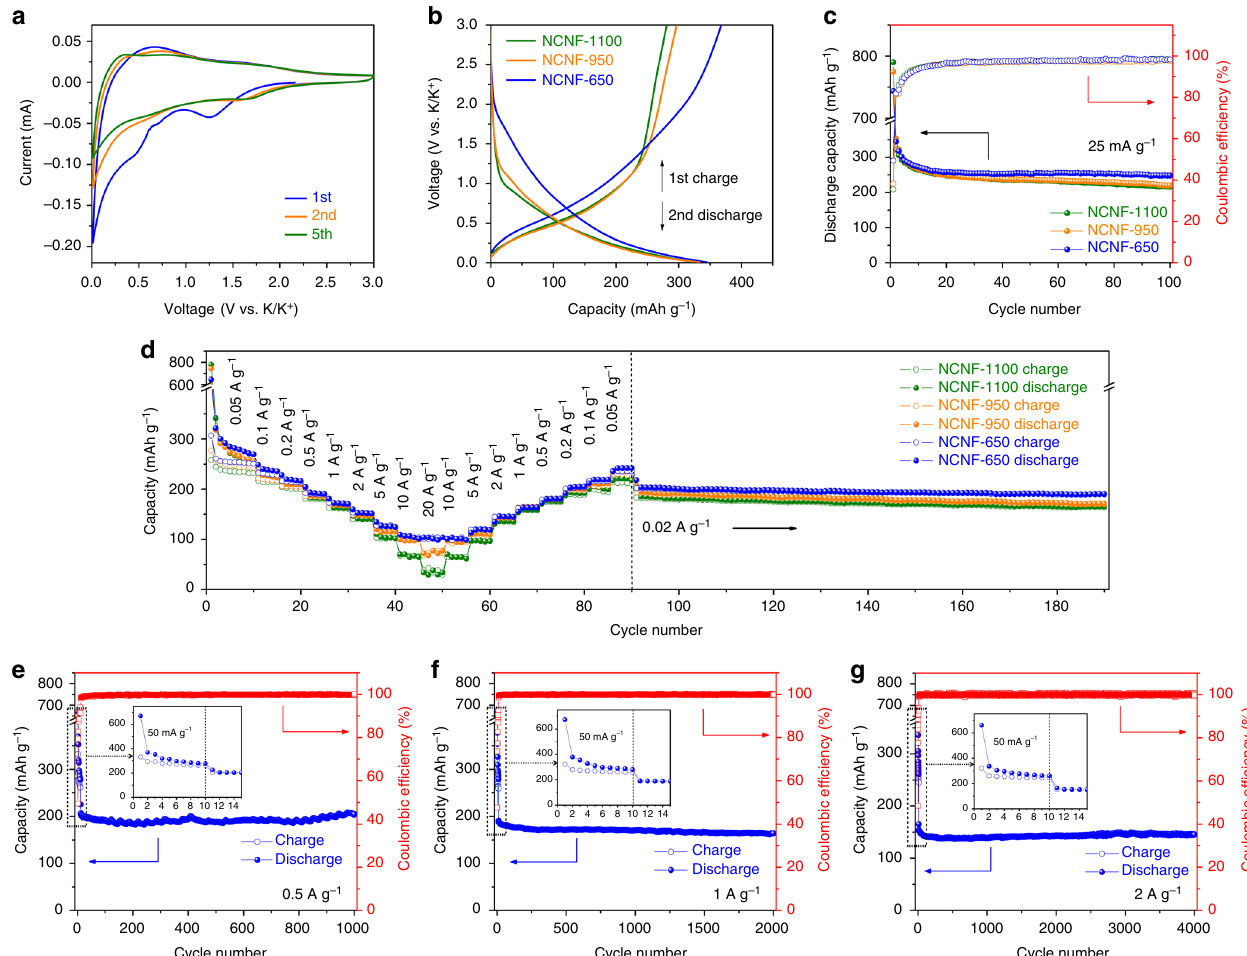
Fig. 3 Electrochemical performance of NCNFs as PIB anodes in half cells. a CV curves of NCNF-650. b First charge and second discharge pro fi les of NCNFs. c Cycling performance of NCNFs at a current density of 25 mA g – 1 . d Rate performance of NCNFs with rates ranging from 0.05 to 20 A g – 1 . Long-term cycling performance of NCNF-650 at high rates of 0.5 ( e ), 1 ( f ), and 2 A g – 1 ( g